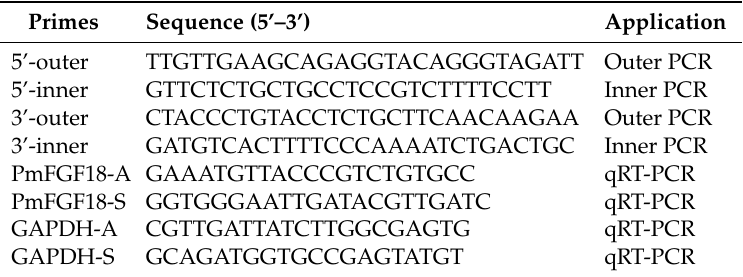
Table 1. Primers used in the present